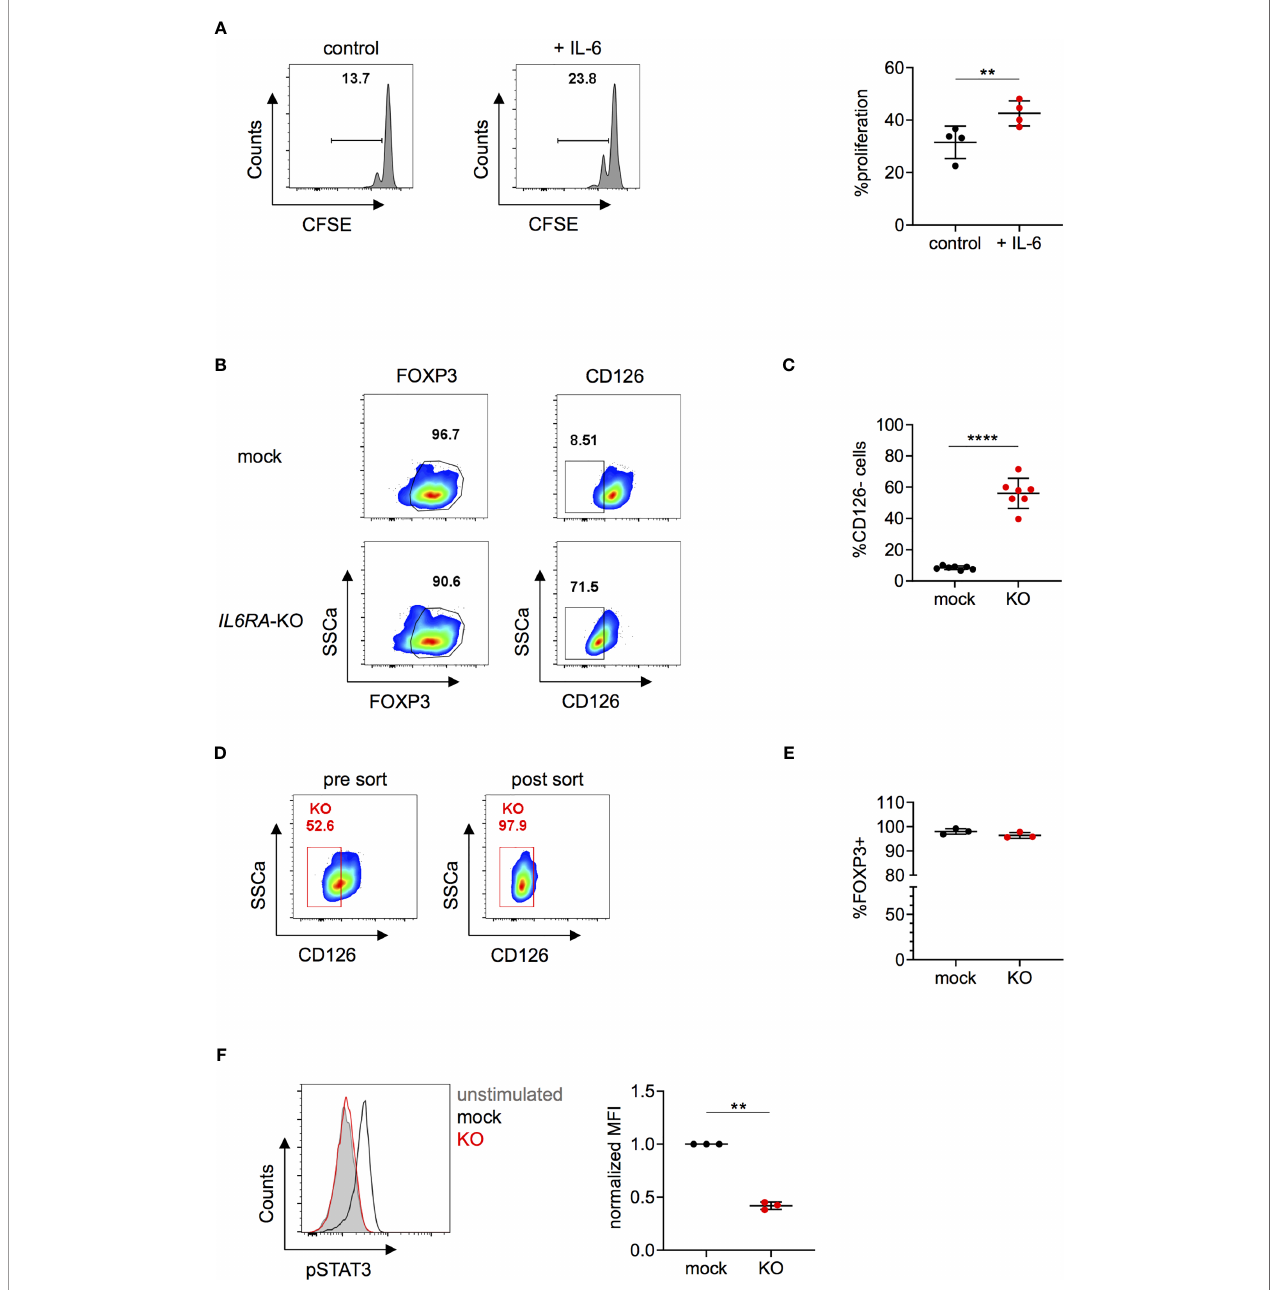
FIGURE 5 | Knock-out of IL6RA in human Tregs impairs IL-6-mediated signaling. (A) Tregs were incubated without (control) or with IL-6 for 24 hours and subsequently cultured in suppression assays with CFSE-labeled PBMCs. FACS plots of one representative experiment (left panel) and data combining 4 independent donors (right panel). Error bars represent mean ± SD. (B – F) Human Tregs were cultured in vitro for 7 days prior gene editing (following protocol described in Figure 1A ). (B) FOXP3 and CD126 expression were analyzed in mock and IL6RA -KO Tregs that were harvested 5 days after RNP nucleofection. FOXP3 plots are pre-gated on living cells and CD126 plots are pre-gated on living FOXP3 + cells. Data are from one representative experiment. (C) CD126 expression was studied in mock and IL6RA-KO Tregs 4 to 7 days after nucleofection in n = 7 independent donors. Error bars represent mean ± SD. (D) RNP-transfected cells were FACS- sorted for CD126 expression and as living (L/D nearIR - ) CD4 + CD25 + CD127 - cells. Left panel represents pre-sorted cells and right panel shows re-analysis post sorting. (E) FOXP3 expression in CD126 - sorted cells (n = 3). Error bars represent mean ± SD. (F) STAT3 phosphorylation was analyzed in CRISPR-edited Tregs. FACS plot of one representative experiment (left panel) and data from 3 independent donors (right panel). Error bars represent mean ± SD. MFI is normalized over IL- 6-stimulated mock. Statistical signi fi cance was calculated by two-tailed t test. **p ≤ 0.01, ****p ≤